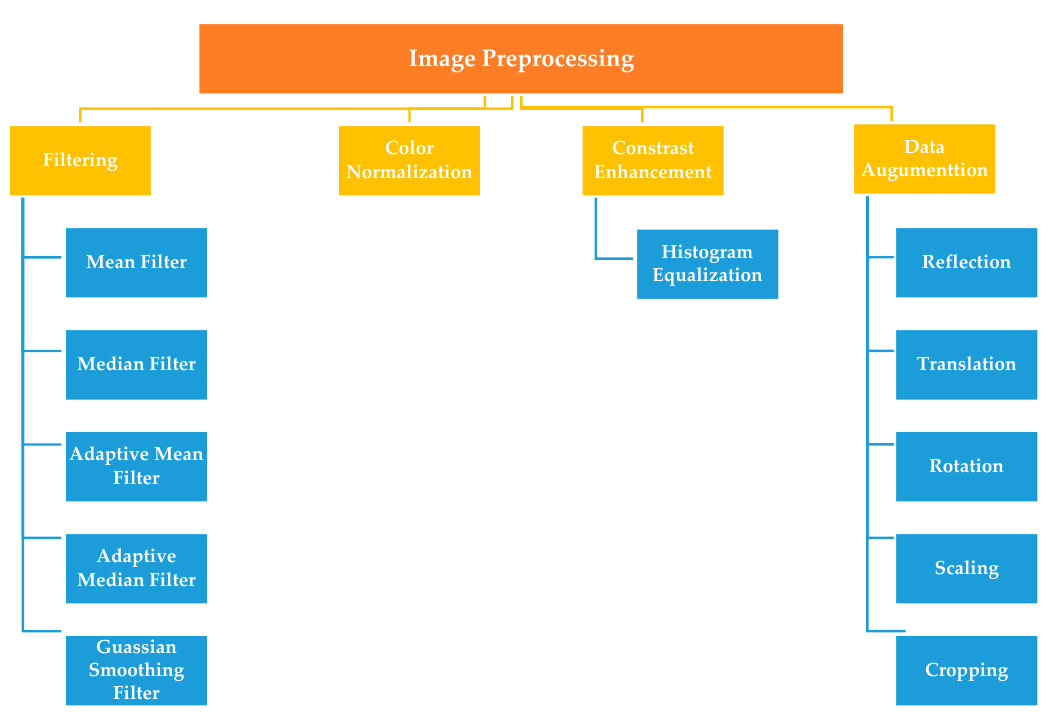
Figure 7. Taxonomy of different image preprocessing methods.